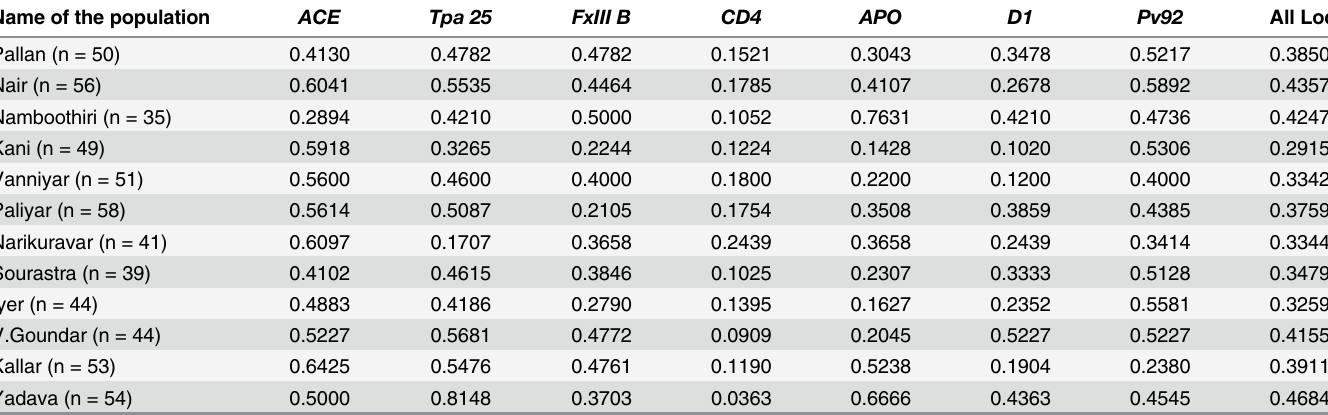
Table 3. Average hetrozygosities based on 7 Alu loci in caste/tribal populations from South India. Name of the population